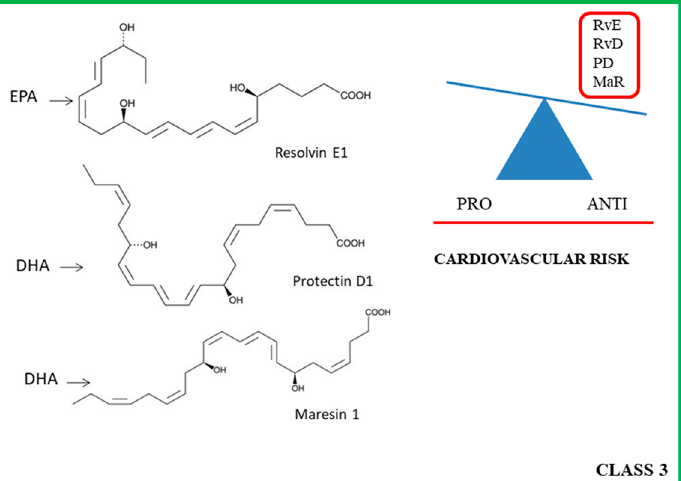
Figure 3. Molecular structure of the principal class 3 lipid mediators (on the left ). On the right , the class 3 lipid mediators are divided according to their anti- and pro-cardiovascular risk properties.